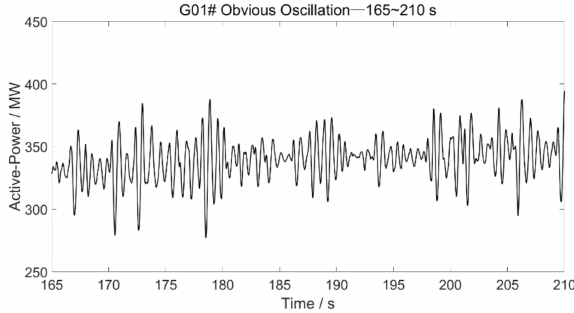
Figure 6. Obvious oscillation signal collected.